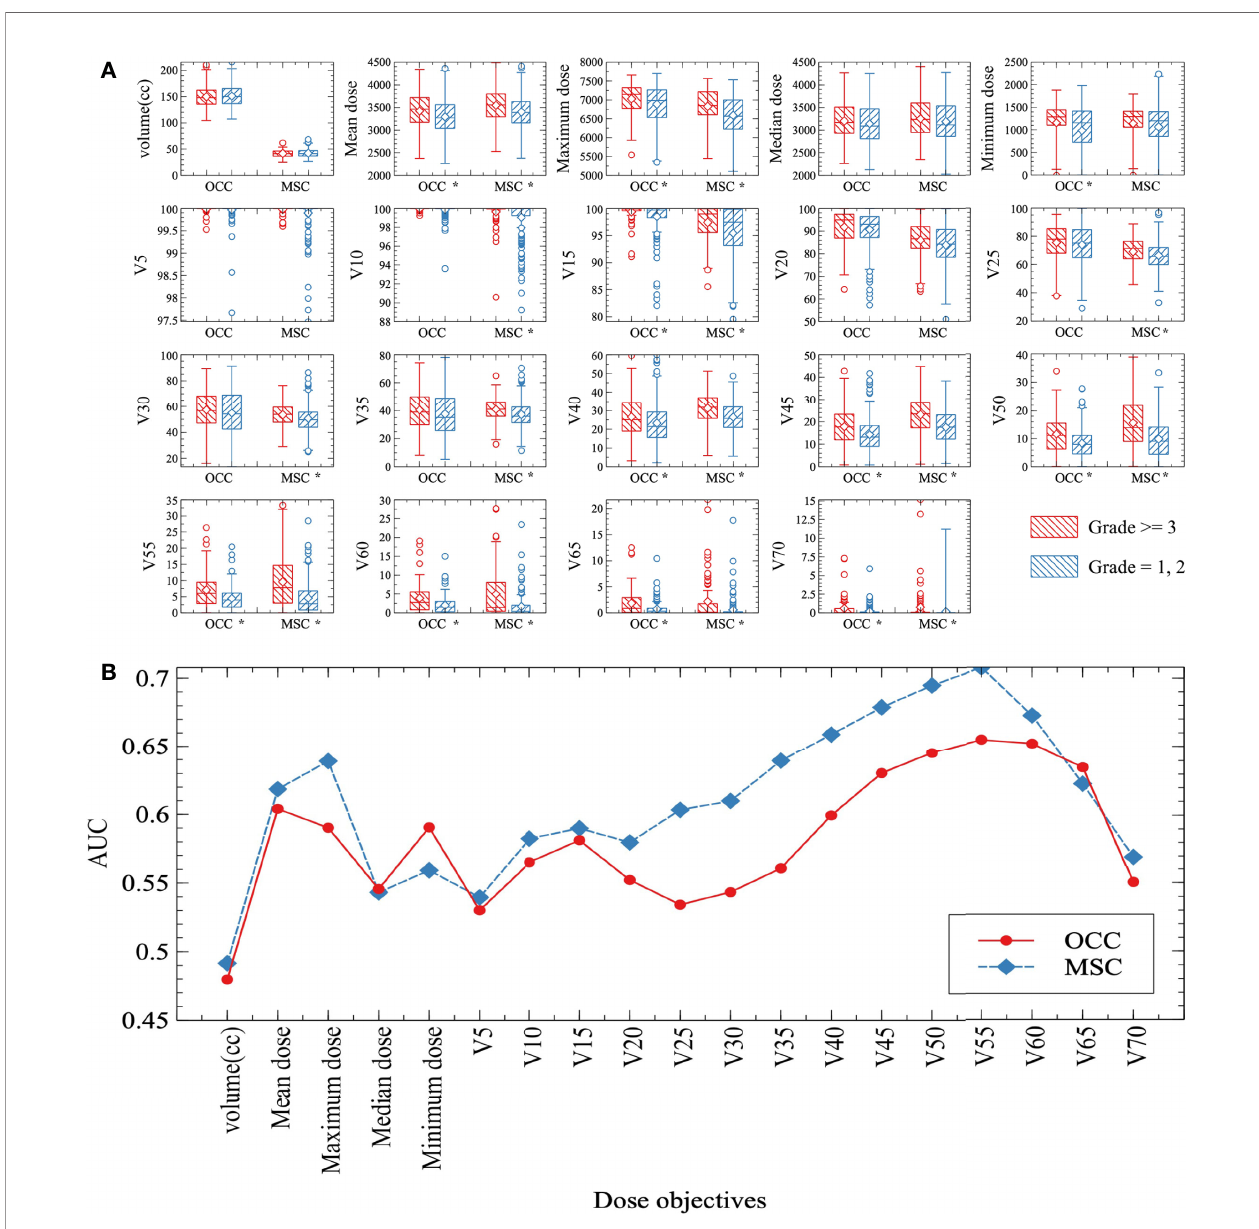
FIGURE 1 | (A) Box plots of dose-volume objectives distributions. Mean values are indicated by the horizontal lines within boxes and median values are represented by the diamonds. Severe oral mucositis group (grade ≥ 3) and non-severe oral mucositis group (grade = 1, 2) data were drawn as red forward diagonal and blue backward diagonal boxes respectively. Note: *Statistically signi fi cant at p=0.05 level. (B) Area under curve (AUC) of all the dose-volume objectives under both oral cavity contour (OCC) (red solid line) and mucosa surface contour (MSC) (blue dashed line) methods. Each AUC is acquired from the ROC curve of each objective. Most dose-volume objectives under MSC method show better performance (higher AUC) than OCC method in terms of predicting severe oral